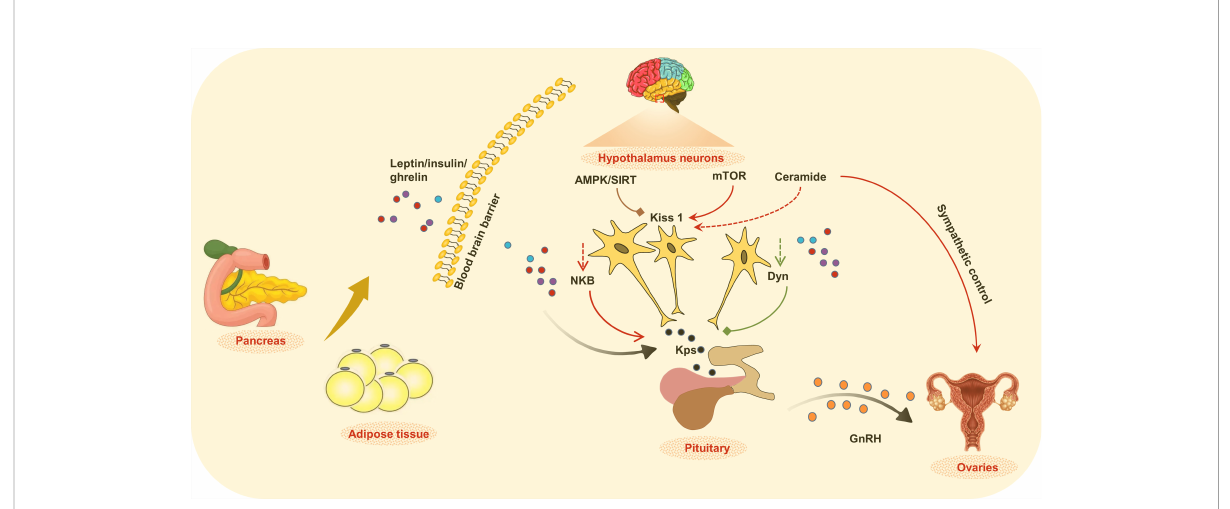
FIGURE 1 The regulation of metabolic and endocrine functions. Alteration of peripheral metabolic status in childhood obesity changed the production and release of cytokines, hormones, lipid, as well as energy sensitive molecules that integrate the control of metabolic signals and central circuits, which together affect the initial of puberty.